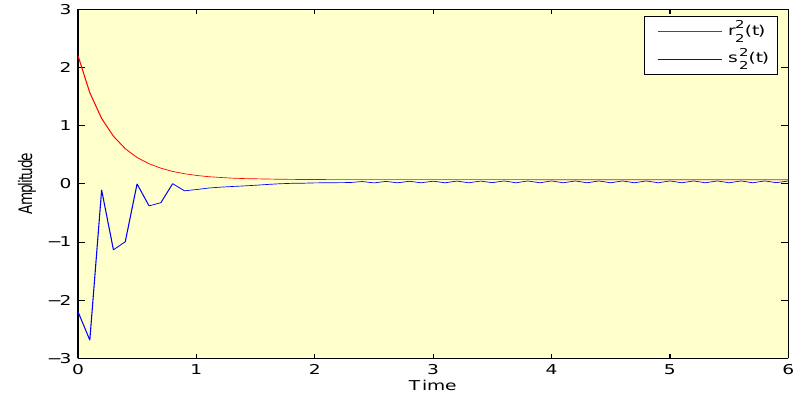
( t ) , (cid:115) 2 ( t ) of NN models (1) and (3). 2 2